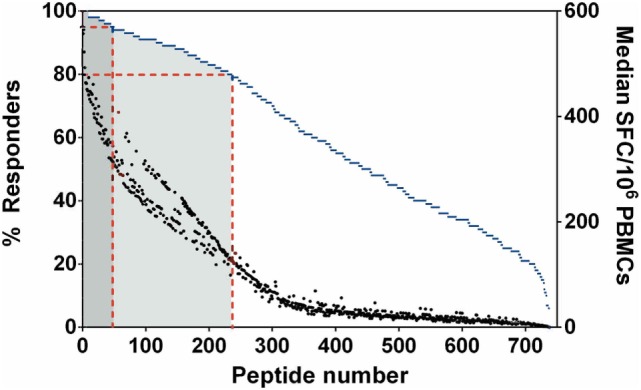
Immunoprevalent peptides identified using Burkholderia pseudomallei antigen peptide libraries in seropositive healthy donors. Peptides were ranked on the basis of % responders from highest to lowest, plotted on the left y-axis (blue dashed line represents % responders = total number of individuals that responded to a particular peptide/number of donors tested). Median spot forming cell (SFC)/106 peripheral mononuclear cell (PBMC) is plotted on the right y-axis (black dot represented for median SFC/106 PBMCs = sum of total SFC/number of donors tested). Red dashed lines indicate the 49 peptides which were recognized by ≥95% of all tested donors (dark gray zone), the 235 peptides which were recognized by ≥80% of all tested donors (light gray zone).